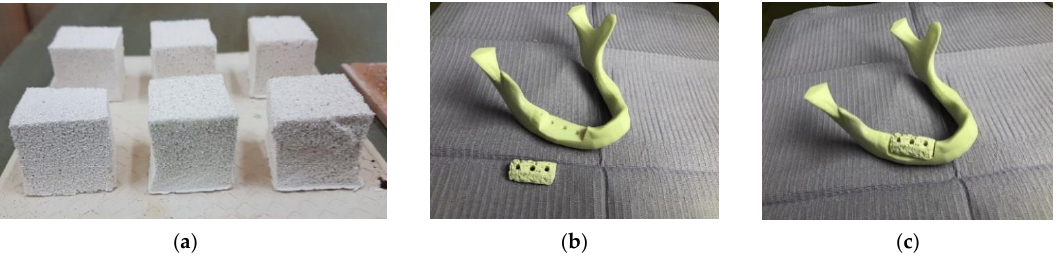
Figure 1. ( a ) Porous ceramic samples that were obtained for the study (cubes with sides of up to 30 mm) — an example from each of the six study groups. An example of the application (with a specific shape of the BC ceramic-based scaffold, manufactured with a different method in [24] (i.e., 3D printing): a mandible ( b ) before and ( c ) after placing the scaffold for bone replacement – as related to our previous study on Finite Element Analysis (FEA) and optimization of the mounting of scaffolds on human mandibles [24]. Further aspects of this application are pointed out in the Section 4. The groups were experimentally named according to the type of ceramic and sponge: Group 1 (GE) : the enamel ceramic (E) is used on the highest density sponge (G). Group 2 (BE) : the enamel ceramic (E) is used on the lowest density sponge (B).